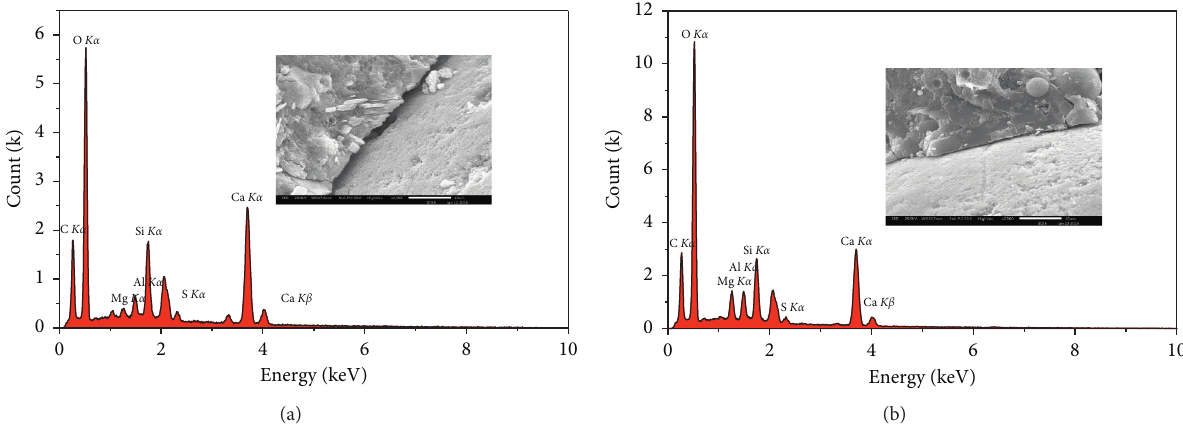
Figure 9: EDS results of the interface of mortar samples with and without mineral admixture at 28d: (a) CCS and (b) CFSCS. CCS: coral mortar; CFSCS: coral mortar with 15% fly ash and 15% slag.